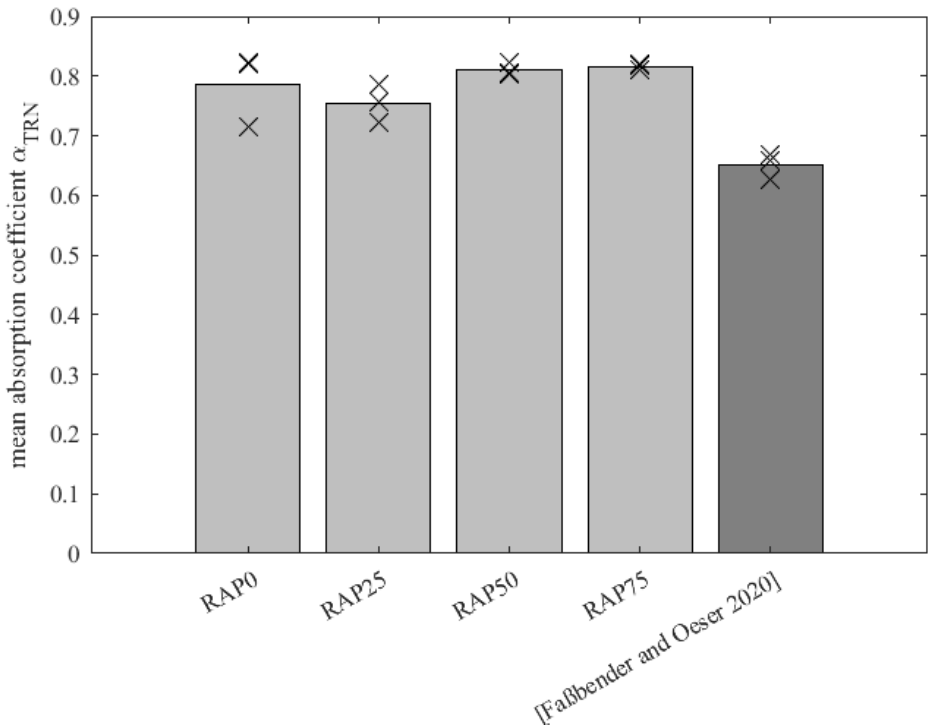
Figure 5. Mean absorption coefficient values of the variants RAP0, RAP25, RAP50, RAP 75 and Ref.